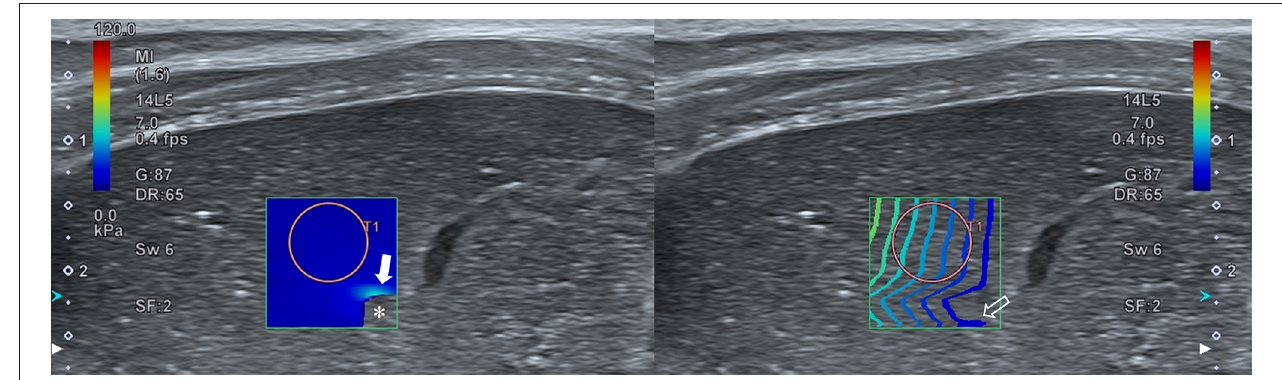
FIGURE 1 | Reliability of hepatic two-dimensional shear wave elastography. A dual-screen mode displays a color map and propagation map on the left and right screens, respectively. Regions with a uniform blue color on the color map and parallel lines with a constant interval on the propagation map represent high reliability. Regions with no color (asterisk) or a focal heterogeneous color (closed arrow) on the color map and distorted, chaotic lines (open arrow) on the propagation map represent low reliability.